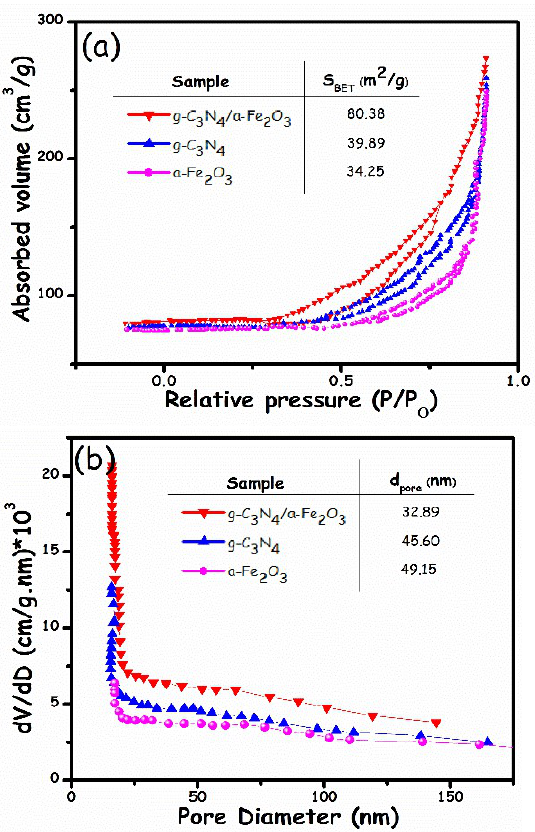
Figure 5. ( a ) N 2 adsorption–desorption isotherms and ( b ) pore size distributions of α -Fe 2 O 3 , g-C 3 N 4 , and α -Fe 2 O 3 /g-C 3 N 4 samples.